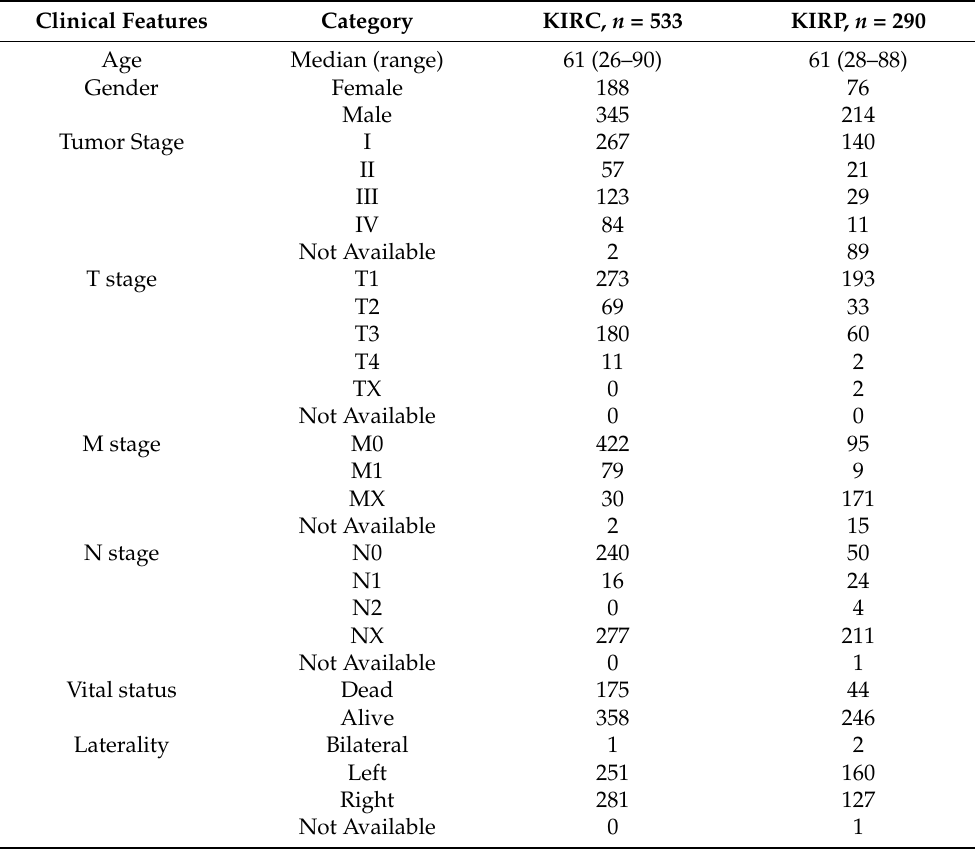
Table 1. Clinical Data of Included Patients from the TCGA